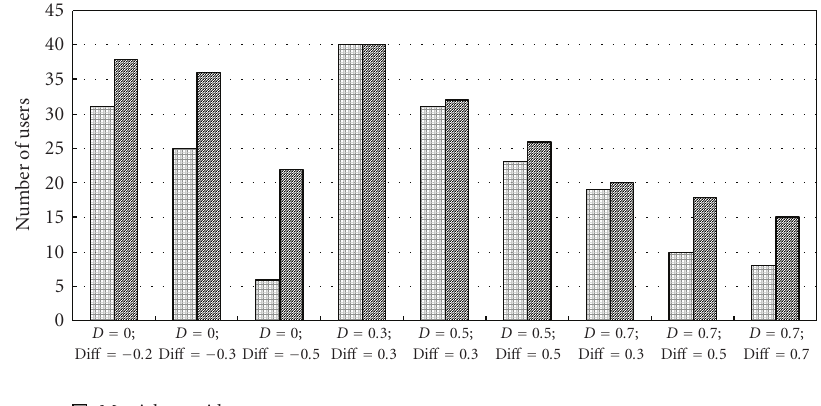
Figure 6: User study on latency and di ff